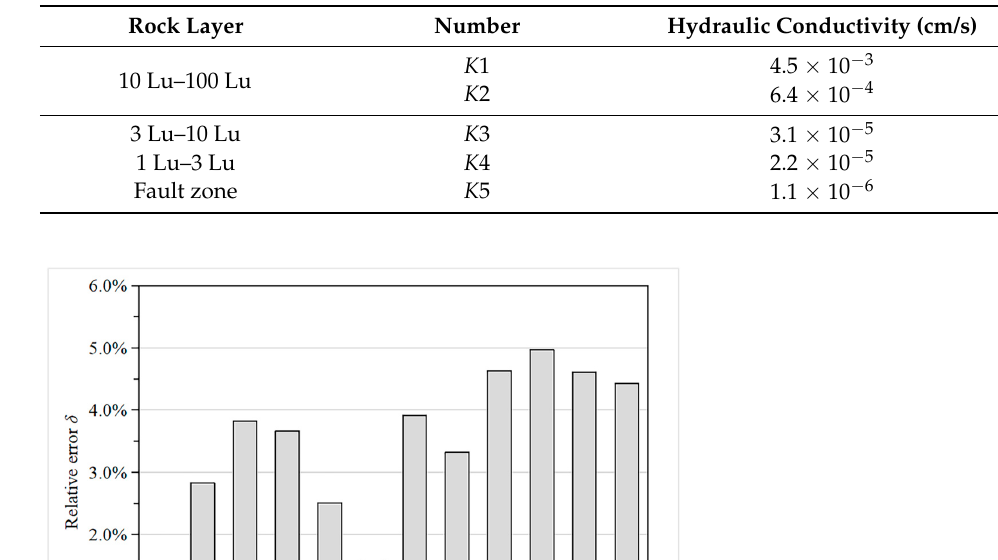
Table 4. Hydraulic conductivity of the Hami dam foundation.